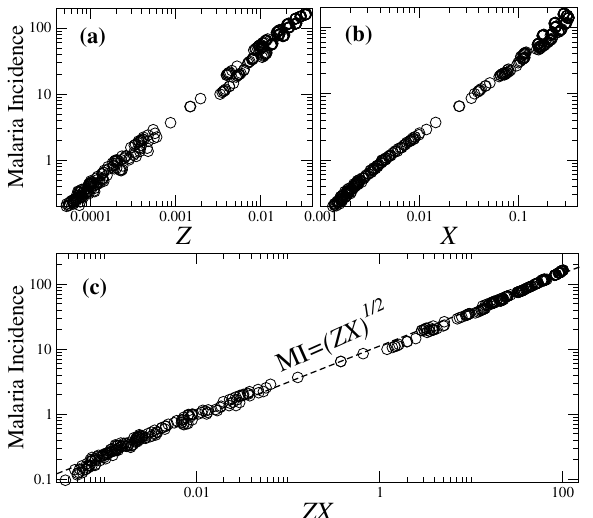
Figure 7. Scatter-plot between annual malaria incidence per 100 inhabitants and ( a ) the Z -rate, ( b ) the X -rate, and ( c ) the ZX -rate. In each case, we merge different levels of heterogeneity and at three different levels of ivermectin treatment, namely p iv = 0.00, 0.10, and 0.20. Independently of the heterogeneous affinity and ivermectin probability, there is a very accurate relationship given by MI ∼